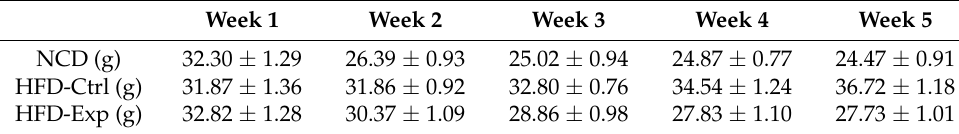
Table 2. Mice body weight.